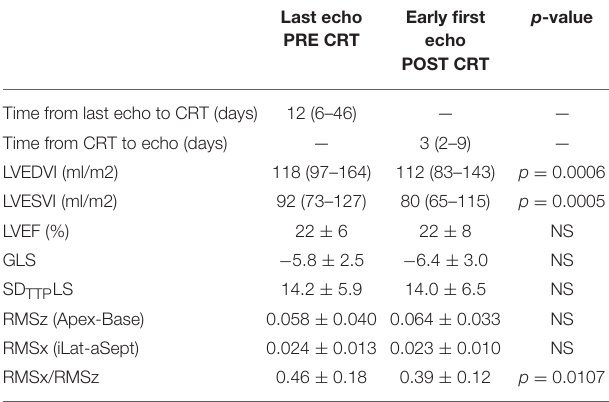
TABLE 2 | Comparison of early changes in main echocardiographic parameters after CRT